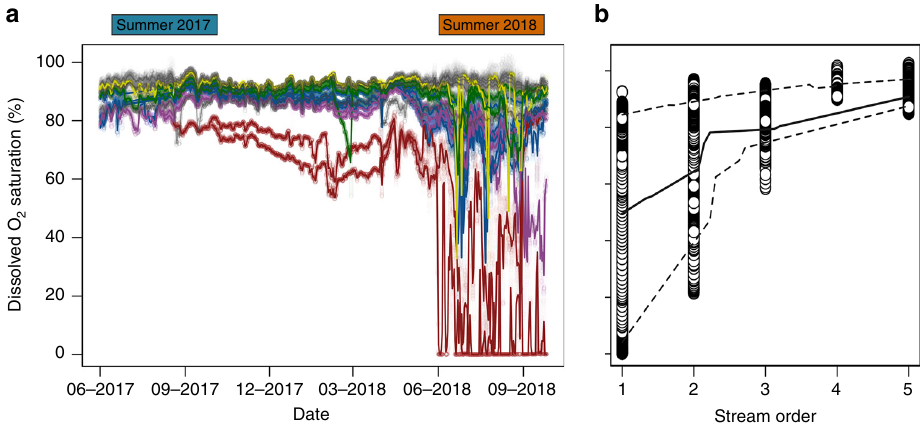
Fig. 5 Network-scale drought altered the stream O 2 availability. a Time series of stream-dissolved O 2 saturation (%) measured at 10-min intervals in the surface water of 16 stream sites across the KCS from June 2017 to October 2018 (shaded circles). Colored lines denote daily averages of O 2 saturation for different headwater streams (i.e., stream order 1 or 2; catchment area < 1.5 km 2 ; n = 9; Supplementary Fig. 1a, Table 1). Gray lines denote daily averages of dissolved O 2 saturation for higher-order streams (i.e., stream order > 2; catchment area > 1.5 km 2 ; n = 7; Supplementary Fig. 1a, Table 1). b Relationship between stream order and dissolved O 2 saturation for the same sites during summer 2018. Lines represent nonparametric 10th (lower dashed line), 50th (solid line), and 90th (higher dashed line) percentile regressions for the entire data